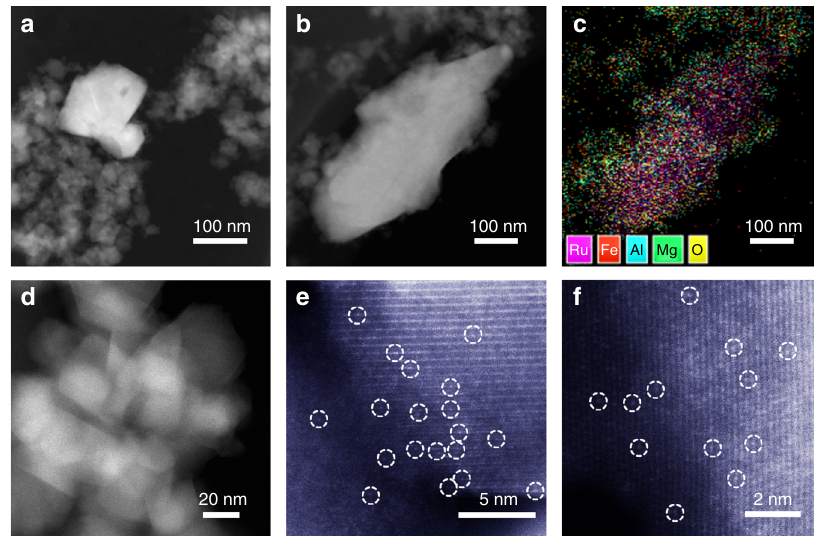
Fig. 1 HAADF-STEM characterization of Ru/MAFO samples. a , b HAADF-STEM images of Ru/MAFO-500 sample. c Energy dispersive X-ray spectroscopy elemental mapping results of Ru/MAFO-500 sample. d – f AC-HAADF-STEM images of Ru 1 /MAFO-900